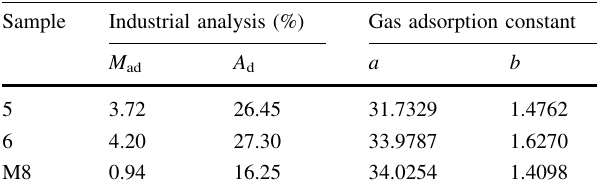
Fig. 9 CO 2 adsorption isotherm curve of No. 6